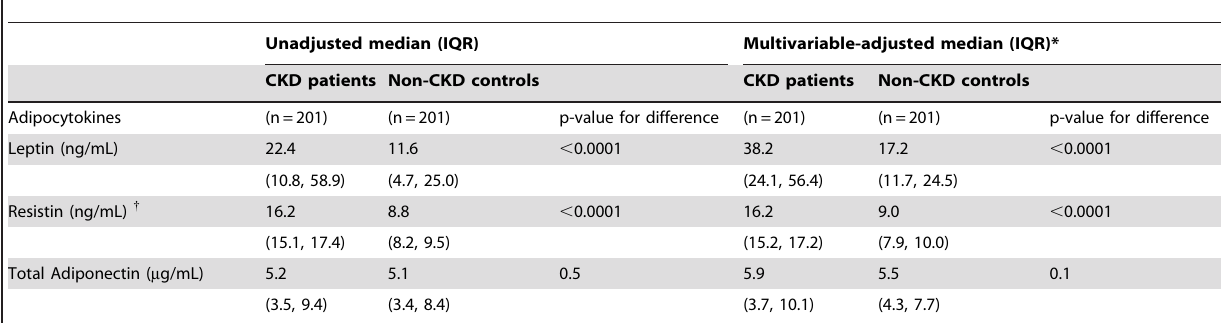
Table 2. Adipocytokine levels according to chronic kidney disease